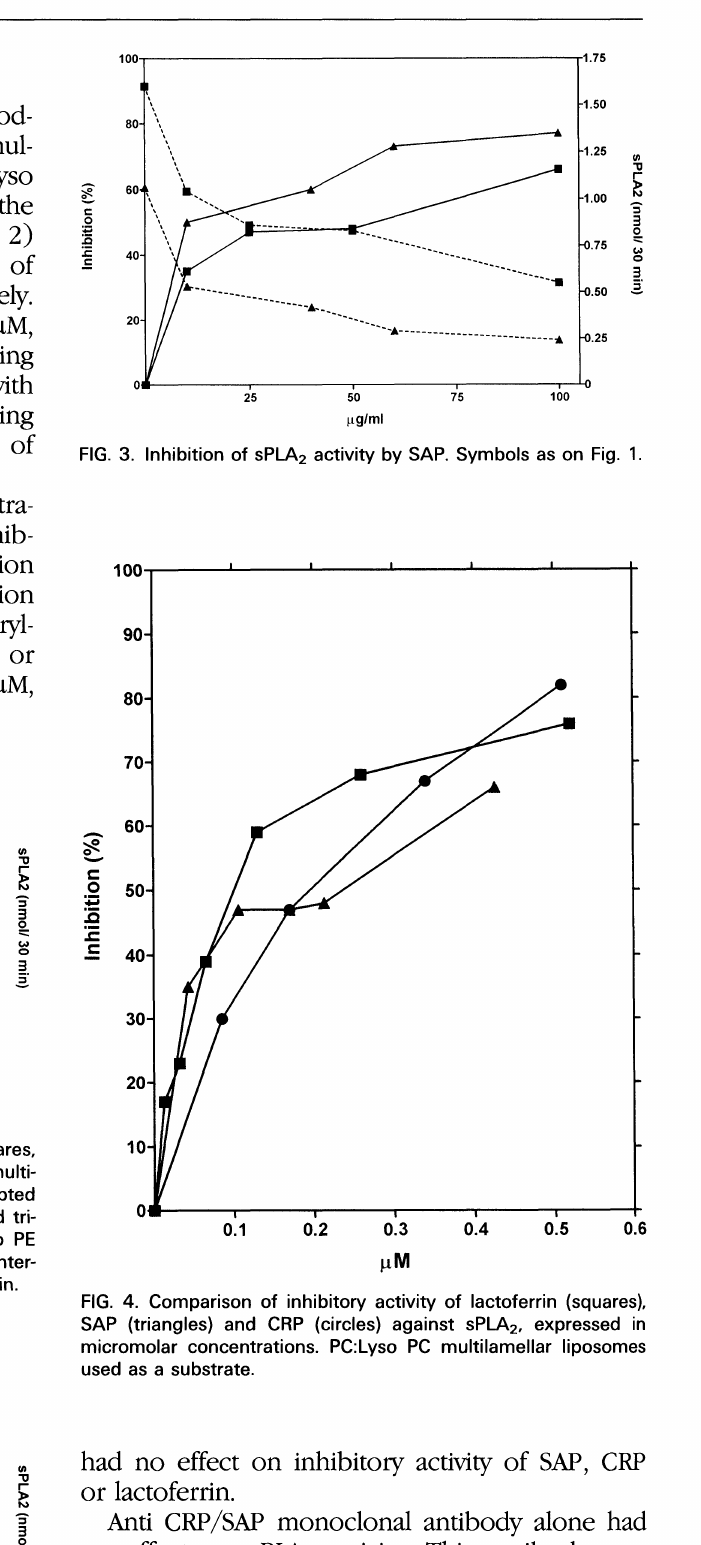
had no effect on inhibitory activity of SAP, CRP or lactoferrin. Anti CRP/SAP monoclonal antibody alone